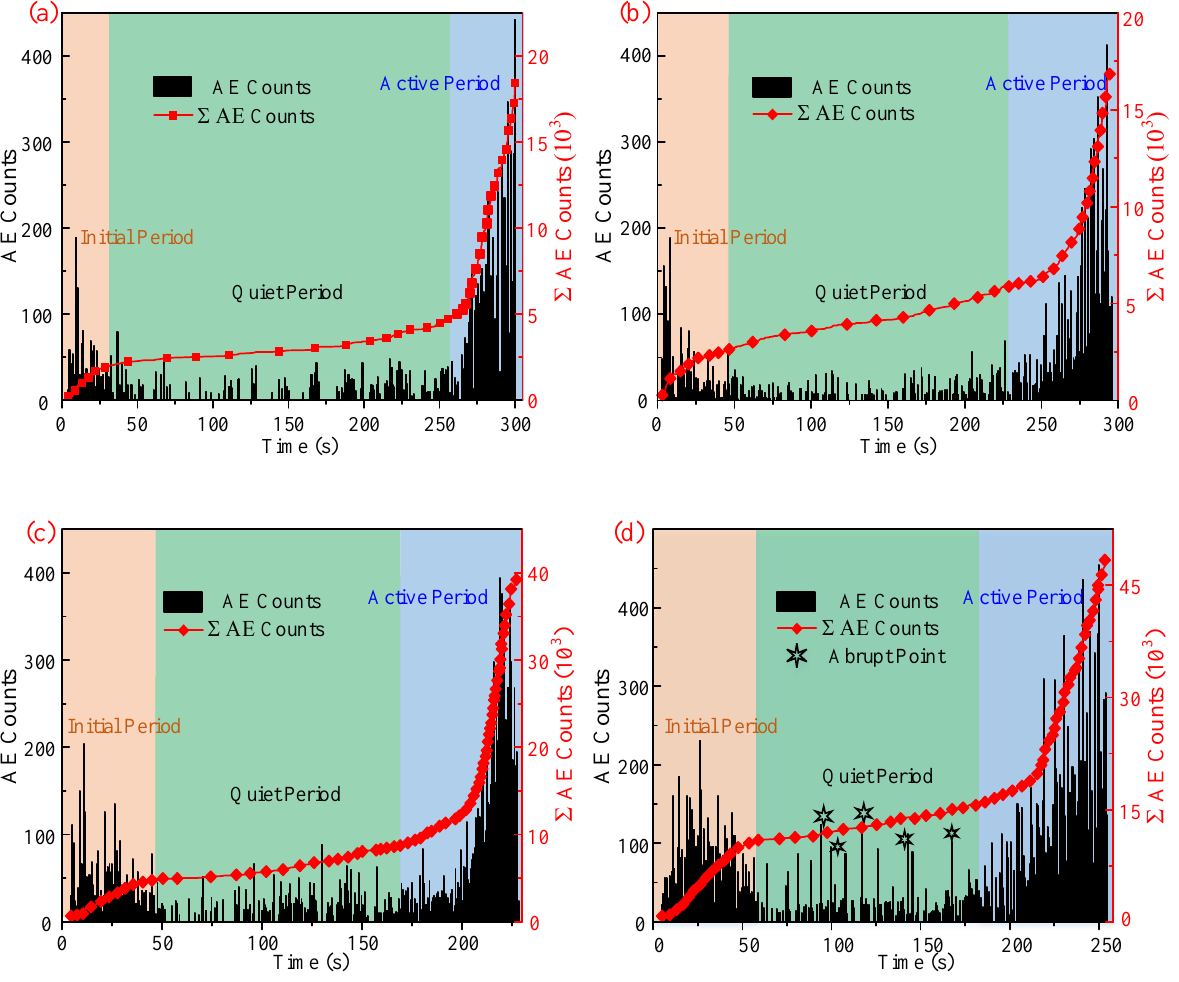
Figure 15. Relationship between the AE counts, cumulative AE counts, and the time of samples with different numbers of F-T cycles under uniaxial compression condition: ( a – d ) represent the tested samples that were subjected to 0, 5, 15, and 30 F-T cycles, respectively.